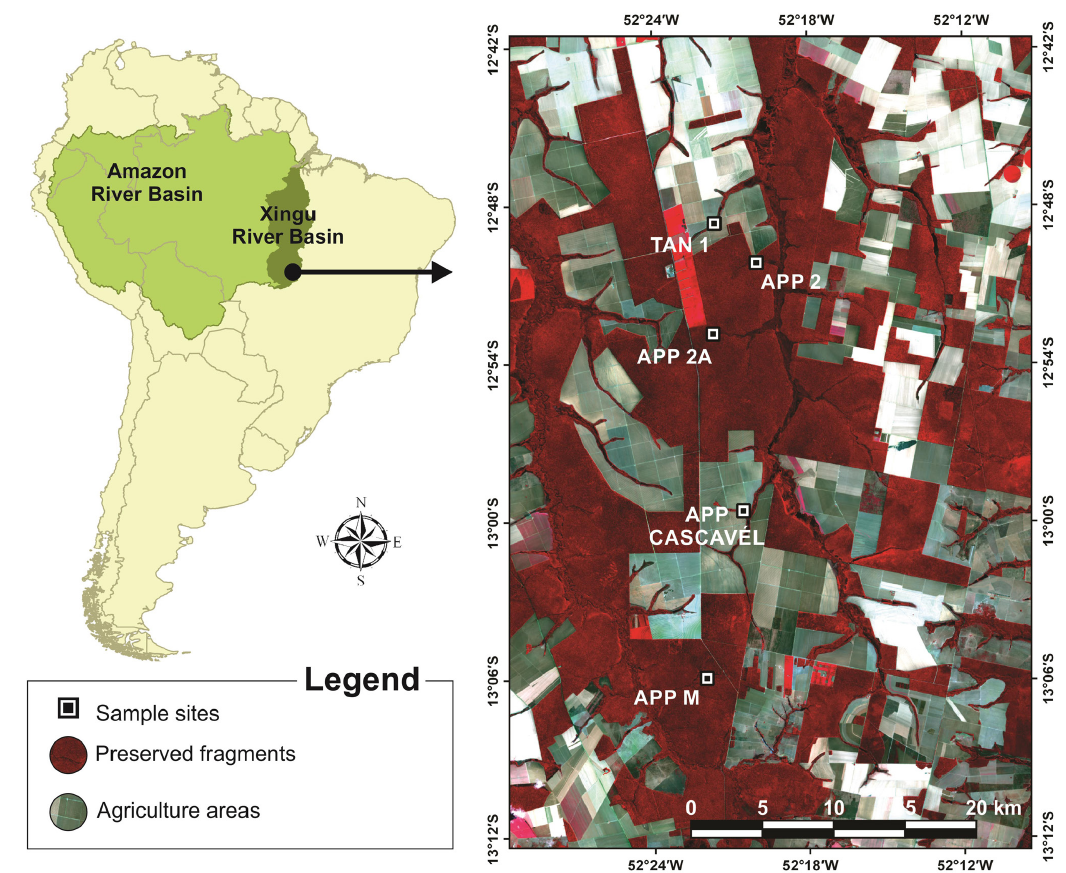
Figure 1. Study area and sampling sites from the Upper Xingu River Basin, satellite image based on Normalized Difference Vegetation Index (NDVI) - composition False Color -bands 5/4/3 – Spacial resolution of 30 meters, LANDSAT 8